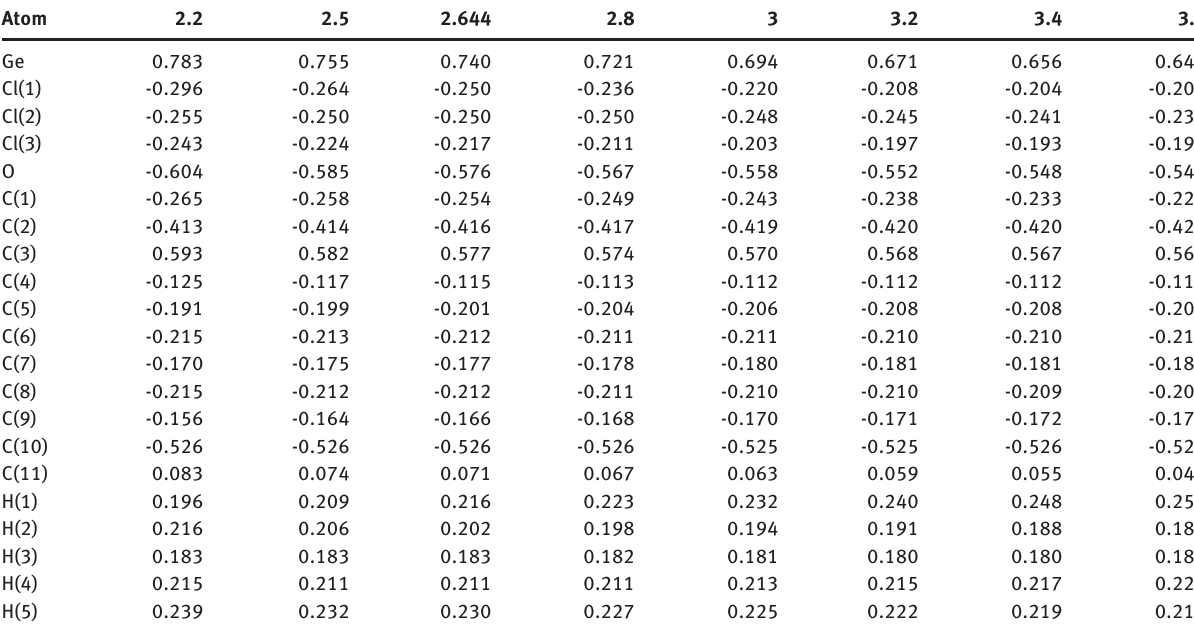
Table 3 The Mulliken ’ s charges (q, e) at the atoms in structure I obtained from the RHF/6-31G(d) calculations at different Ge ‧ ‧ ‧ O distances [r(Ge ‧ ‧ ‧ O), Å